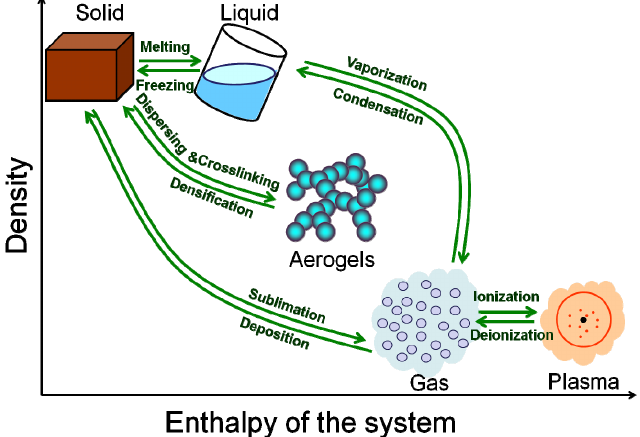
Figure 1. The distribution and transition of different states of matter in “density” vs . “enthalpy of the system”